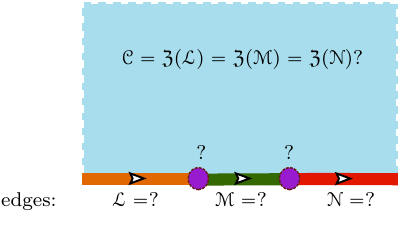
Figure 2 . Obvious questions about gapless edges of a 2d chiral topological